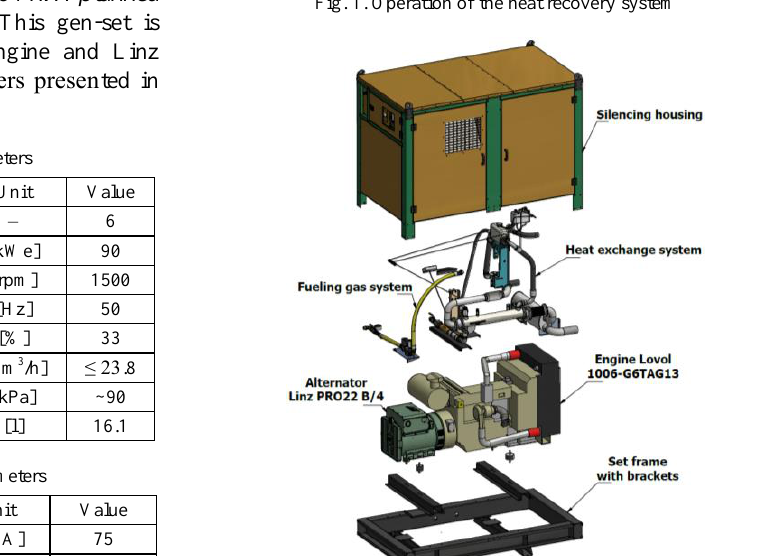
Fig. 1. Operation of the heat recovery system